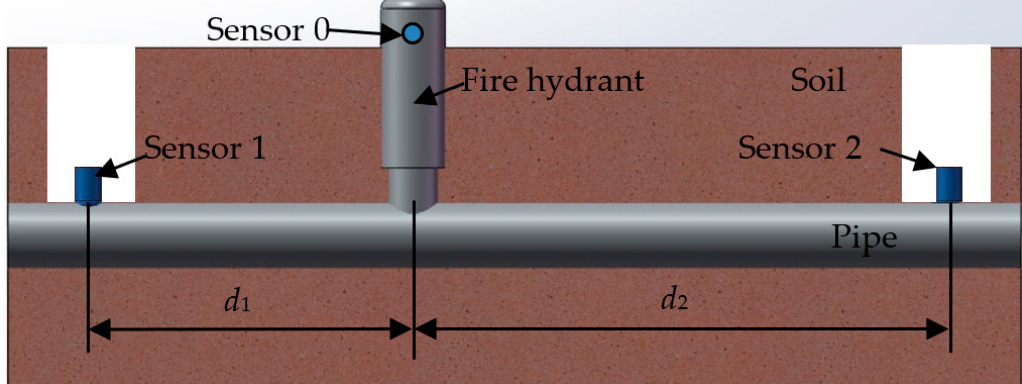
Figure 4. Schematic of the set-up for acoustic wave propagation estimation. Table 2. The real and imaginary parts of the test wavenumber.